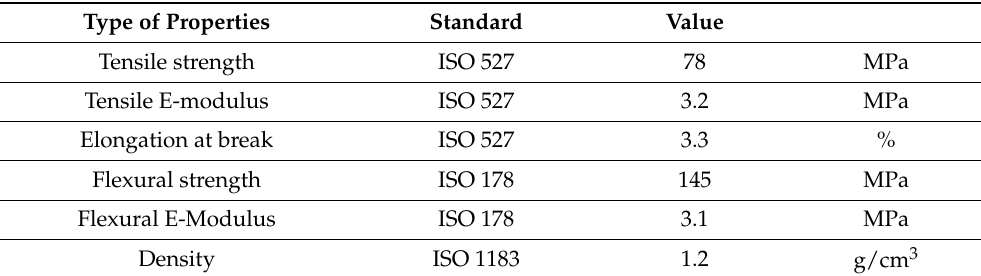
Table 2. Mechanical data from the technical datasheet, properties after 3 h/80 ◦ C + 3 h/120 ◦ C + 3 h/140 ◦